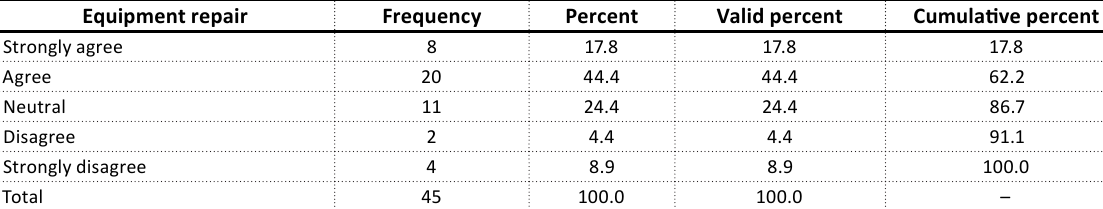
Table 3. Frequency showing the equipment repair Equipment